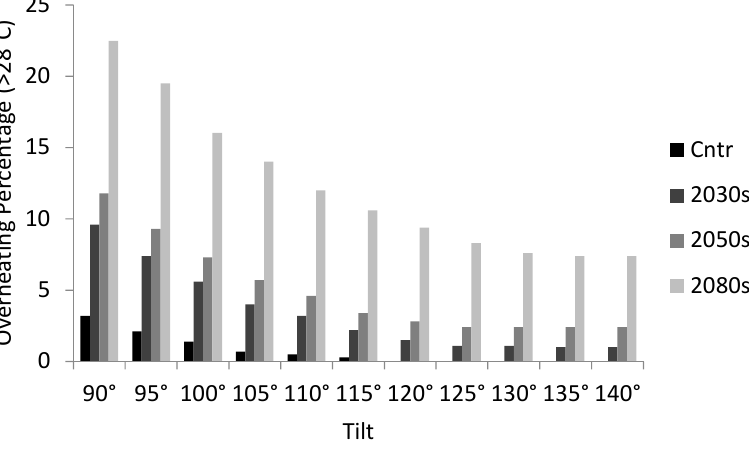
Figure 7. Frequency of overheating in the pilot study unit percentage of occupied hours the indoor operative temperatures exceeds 28